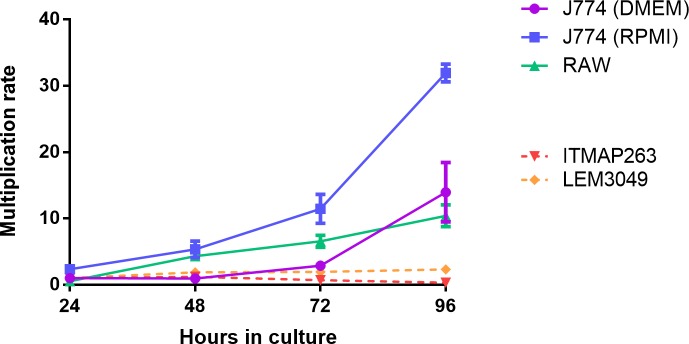
Multiplication rate of J774 and RAW cells in relation to the intracellular growth of ITMAP-263 (not showing significant intracellular multiplication in PECs) and LEM3049 (showing rapid intracellular replication in PECs).Although both Leishmania strains demonstrate intracellular replication, parasitized cells become outcompeted because of the more rapid expansion of non-infected host cells, resulting in low infection ratios. Multiplication rates are expressed as the average ± SEM of two independent experiments run in duplicate.